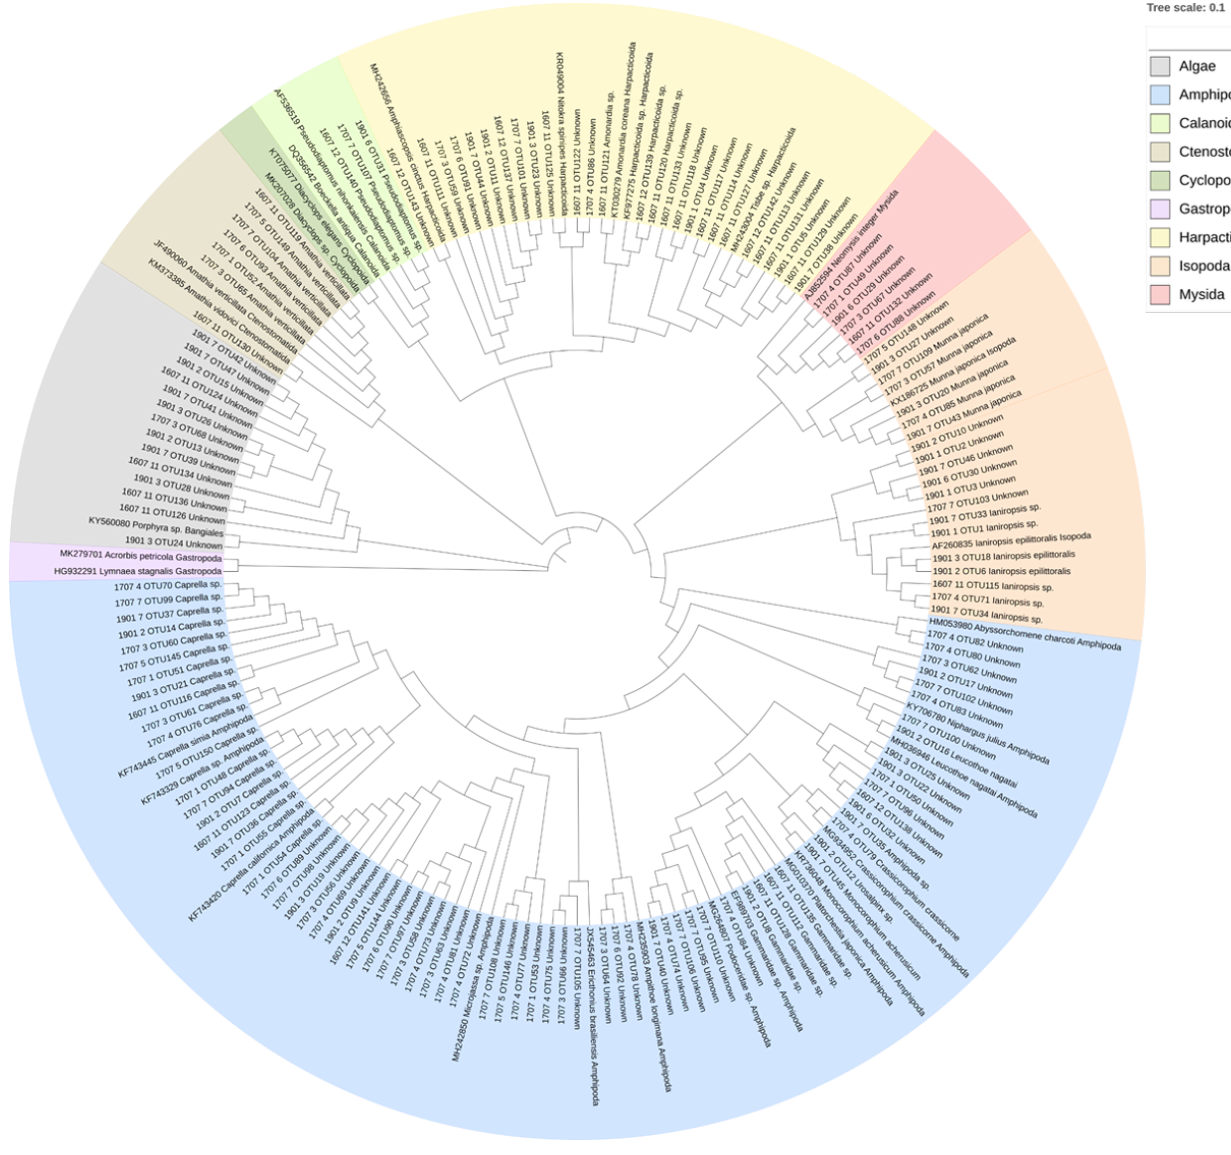
Figure 3. Phylogenetic tree of gut contents.